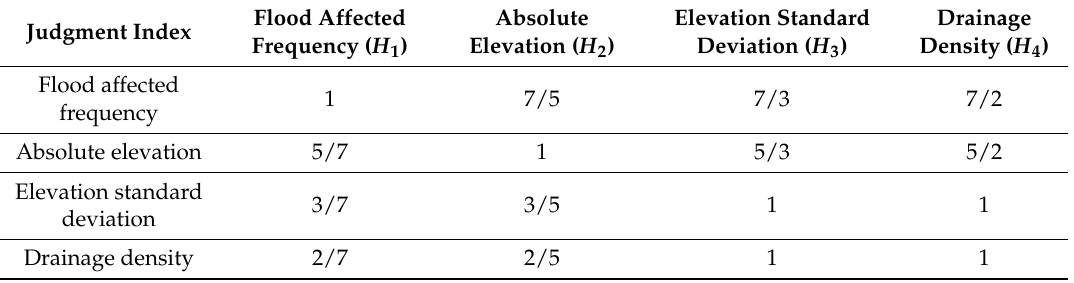
Table 4. Judgment